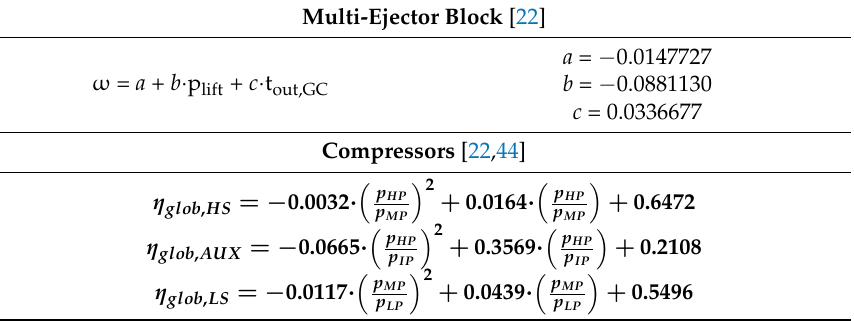
Table 11. Correlations employed for simulating the multi-ejector based solution